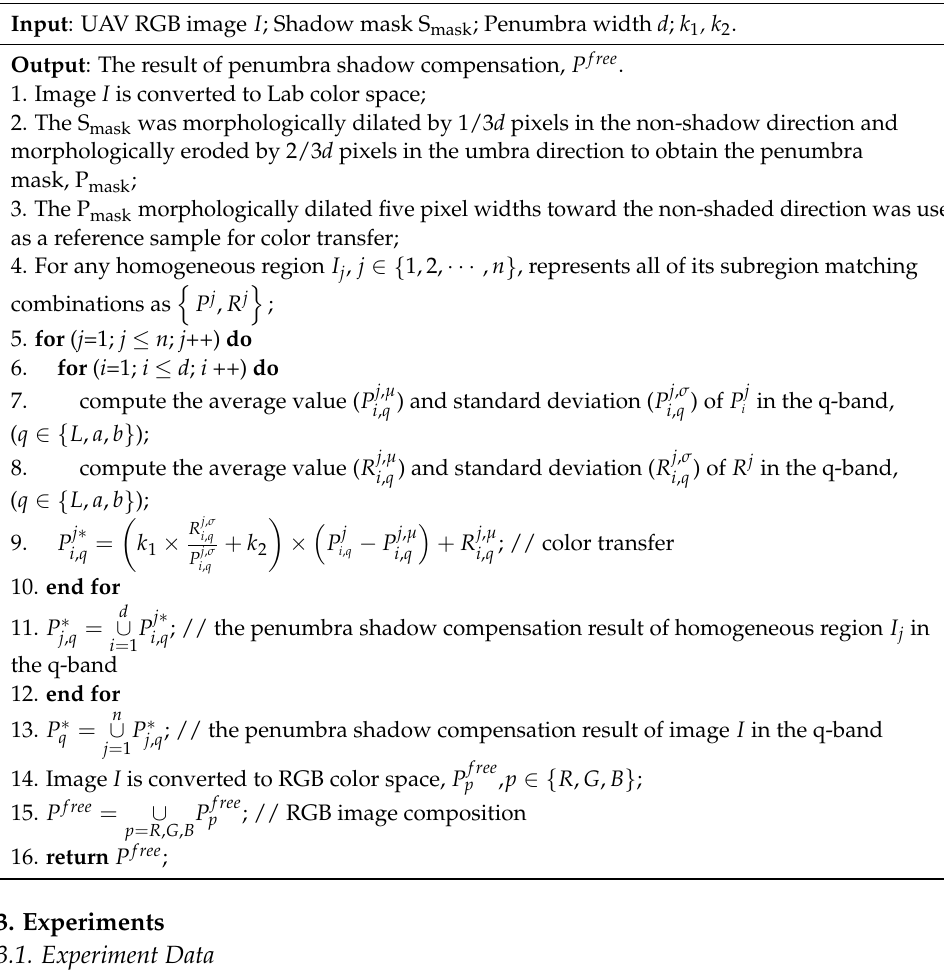
Algorithm 2. Penumbra compensation